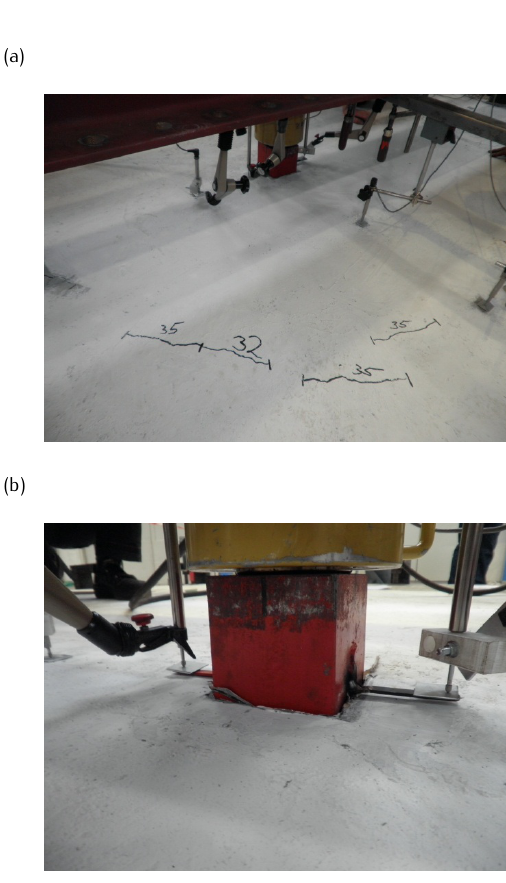
Figure 8. Crack patterns and failure for centre load